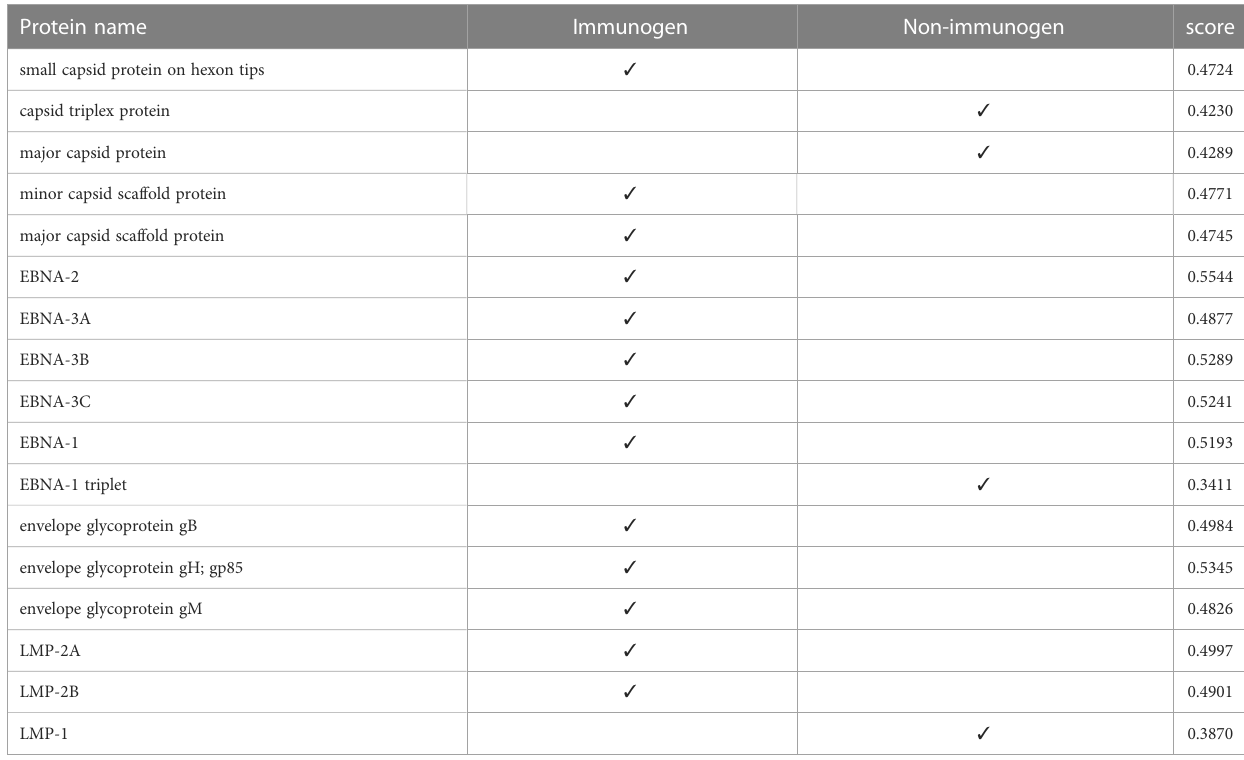
TABLE 5 Immunogenicity of human herpesvirus 4 (strain 2)